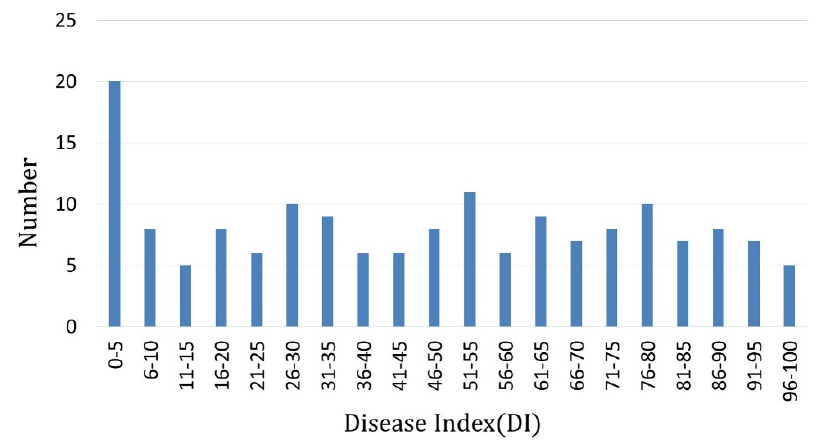
Figure 2. Distribution of F 2:3 families’ disease levels (disease index) after testing with Pbh of P. brassicae